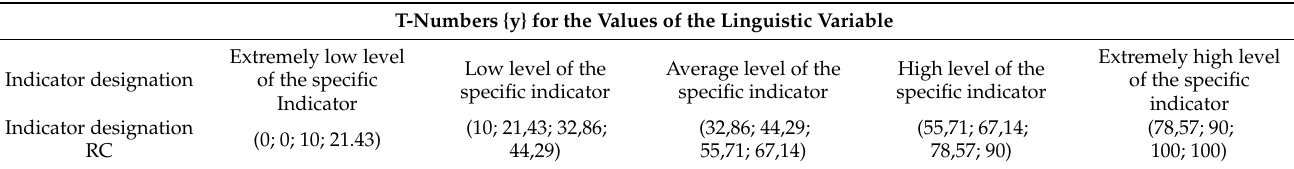
Table 36. Indicators of the level of responsible consumption.